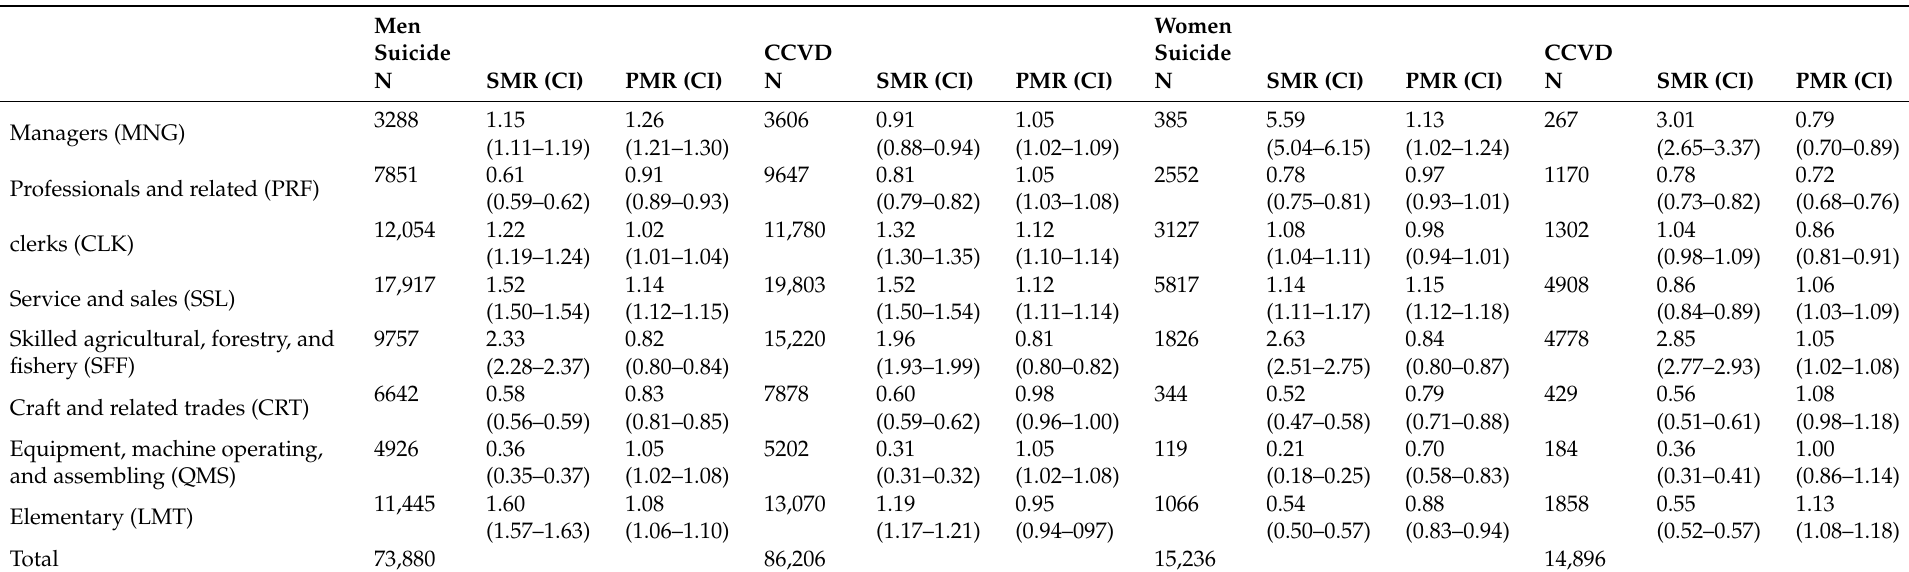
Table A1. SMR and PMR of suicide and CCVD by occupation for 24 years (1997–2020).